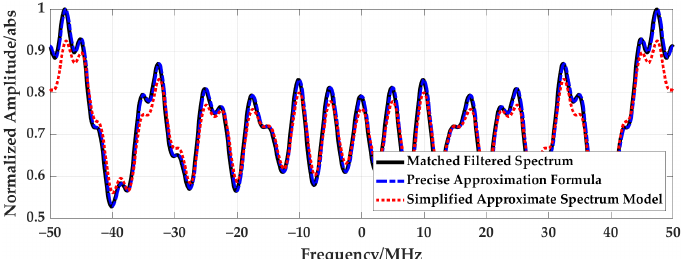
Figure 7. Simulation result of the match-filtered spectrum and the corresponding numerical results based on precise approximation formula and simplified approximate formula.